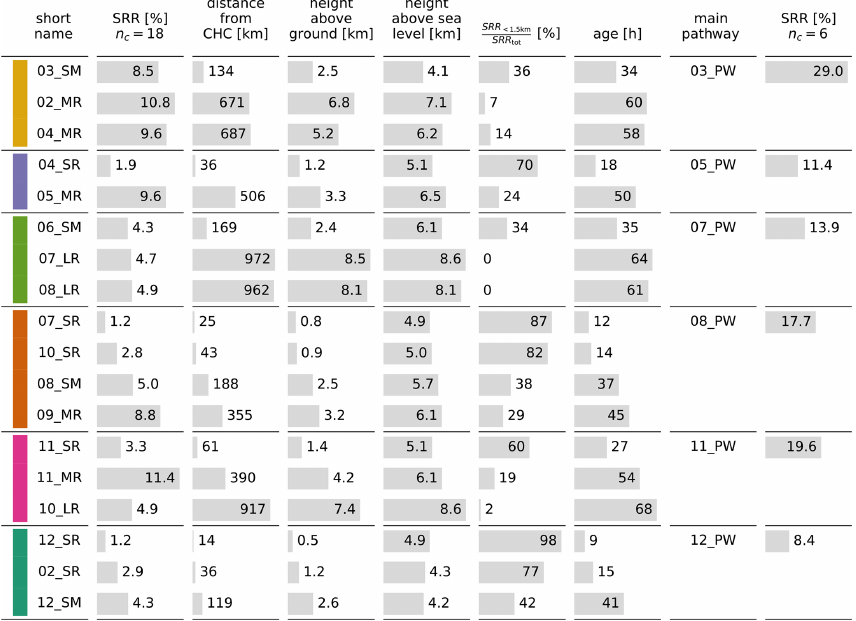
Figure 13. Properties of the 18 clusters ( n c = 18). The short name’s digits refer to the clockwise direction of the centre of mass of each cluster. The letters refer to the range: SR – short range, SM – short-medium range, MR – medium range and LR – long range. The SRR [%] column describes the average contribution of each cluster. We also show the distance from CHC, height above ground and height above sea level of each cluster’s centre of mass. Furthermore, SRR < 1 . 5km [%] shows the ratio between the SRR below 1.5km and the SRR summed SRR total over the full vertical column (SRR total ). The age column shows the weighted median time (in hours) required by the air masses to arrive from the respective cluster to CHC. The last two columns describe the results of clustering the 18 clusters into 6 clusters (main pathways, n c = 6). The digits also refer to the clockwise direction. The last column adds up the SRR [%] of the cluster belonging to each main pathway. The colours in the first column correspond to the six pathways and associated colours shown in Figs. 6a and b, 7, and